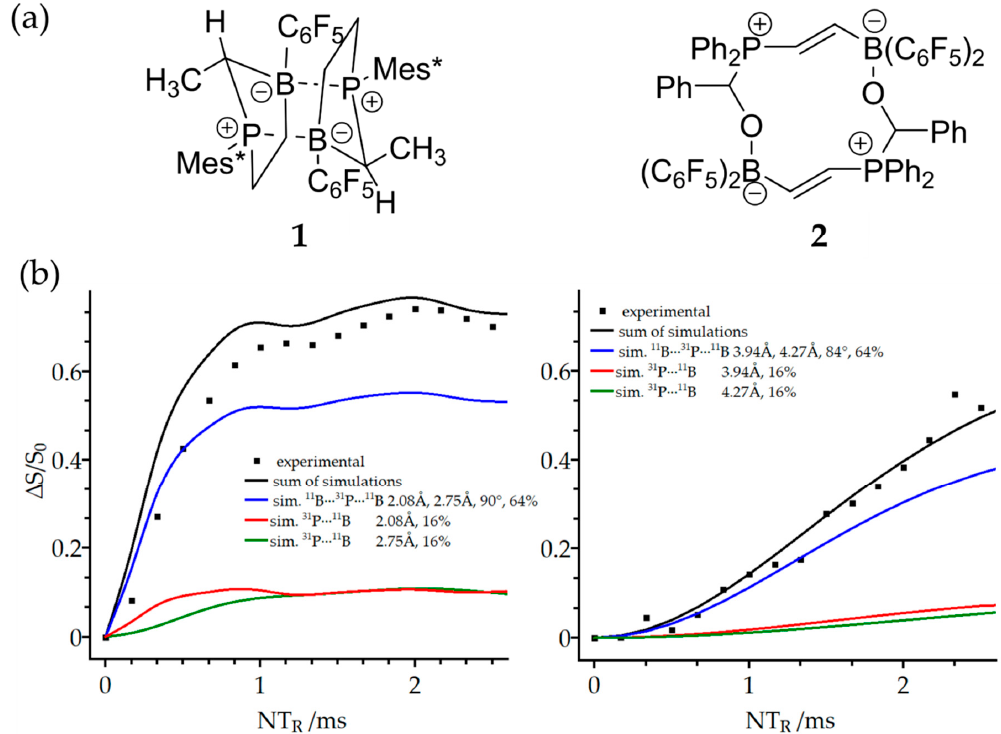
Figure 16. ( a ) Schematic representation of B/P FLP dimer and dimeric adduct of a B/P FLP with benzaldehyde and ( b ) characterization of both compounds using 31 P{ 11 B} REAPDOR experiments. The